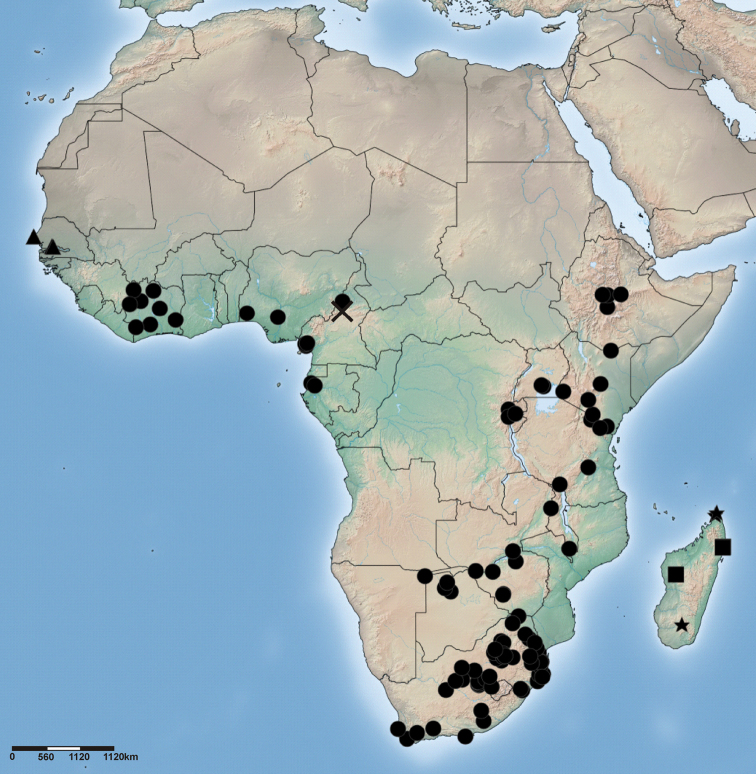
Distribution of Cambalida fulvipes (Simon, 1896) (circles), Cambalida griswoldi sp. n. (stars), Cambalida lineata sp. n. (squares), Cambalida loricifera (Simon, 1885) (triangles) and Cambalida unica sp. n. (cross) in the Afrotropical Region.